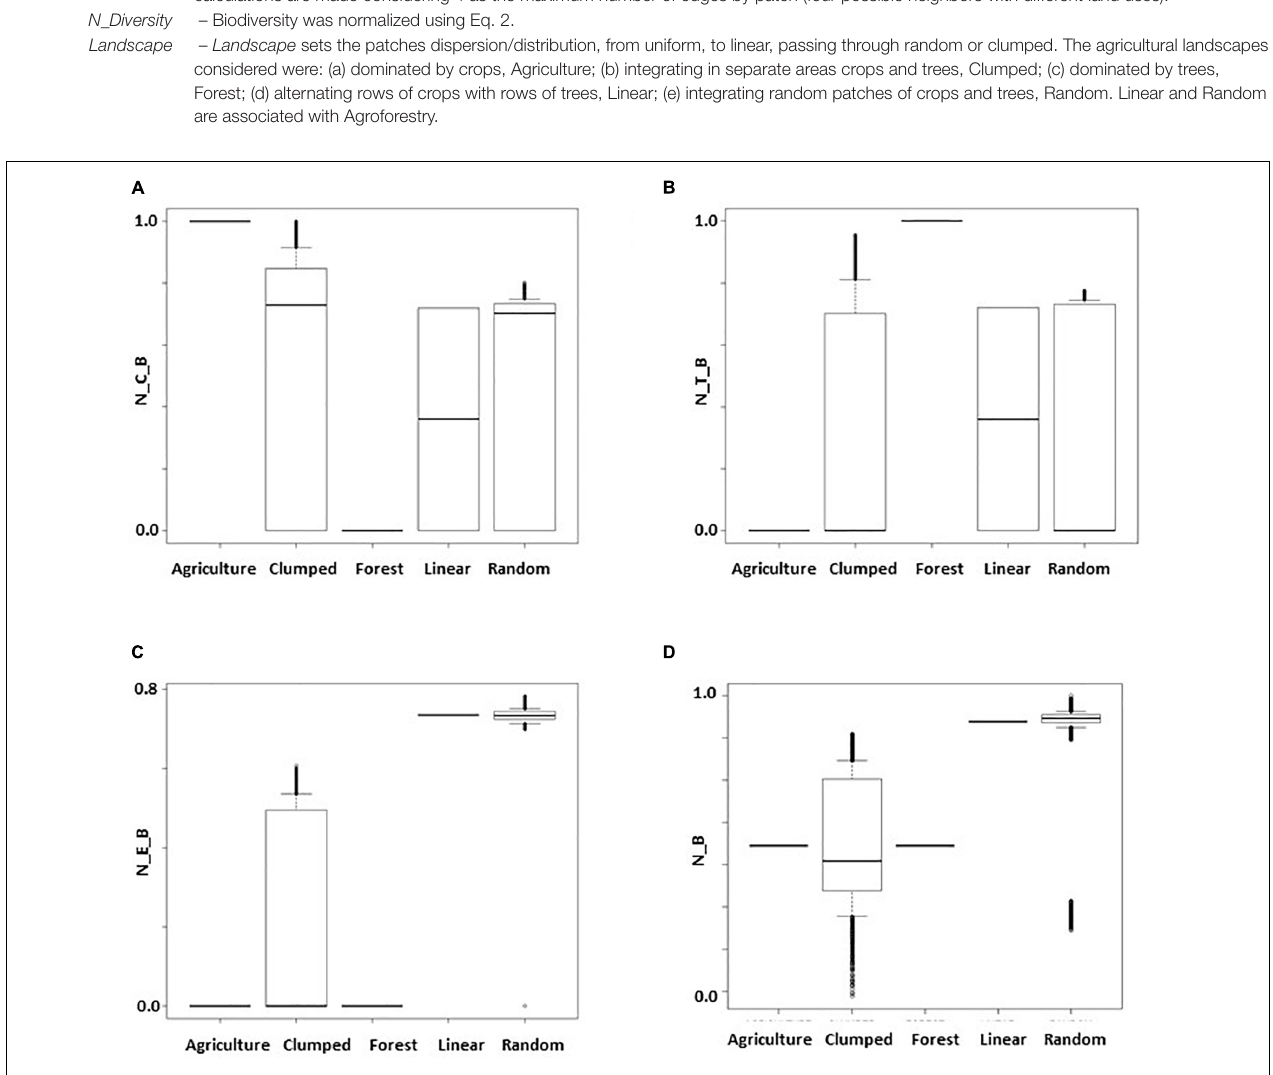
FIGURE 2 | Box and Whisker plots expressing the differences in the Biodiversity metrics associated with the different Agricultural landscapes simulated: (A) normalized Crop Biodiversity (N_C_B); (B) normalized Tree Biodiversity (N_T_B); (C) normalized Edge Biodiversity (N_E_B); (D) normalized Biodiversity (N_B). Medians for N_C_B: Agriculture, 1.000; Clumped, 0.728; Forest, 0.000; Linear, 0.360; Random, 0.702. Medians for N_T_B: Agriculture, 0.000; Clumped, 0.000; Forest, 1.000; Linear, 0.360; Random, 0.000. Medians for N_E_B: Agriculture, 0.000; Clumped, 0.000; Forest, 0.000; Linear, 0.735; Random, 0.735. Medians for N_B: Agriculture, 0.645; Clumped, 0.609; Forest, 0.645; Linear, 0.938; Random, 0.945. Associated Steel-Dwass multiple comparisons tests in Supplementary Appendixes 1–4